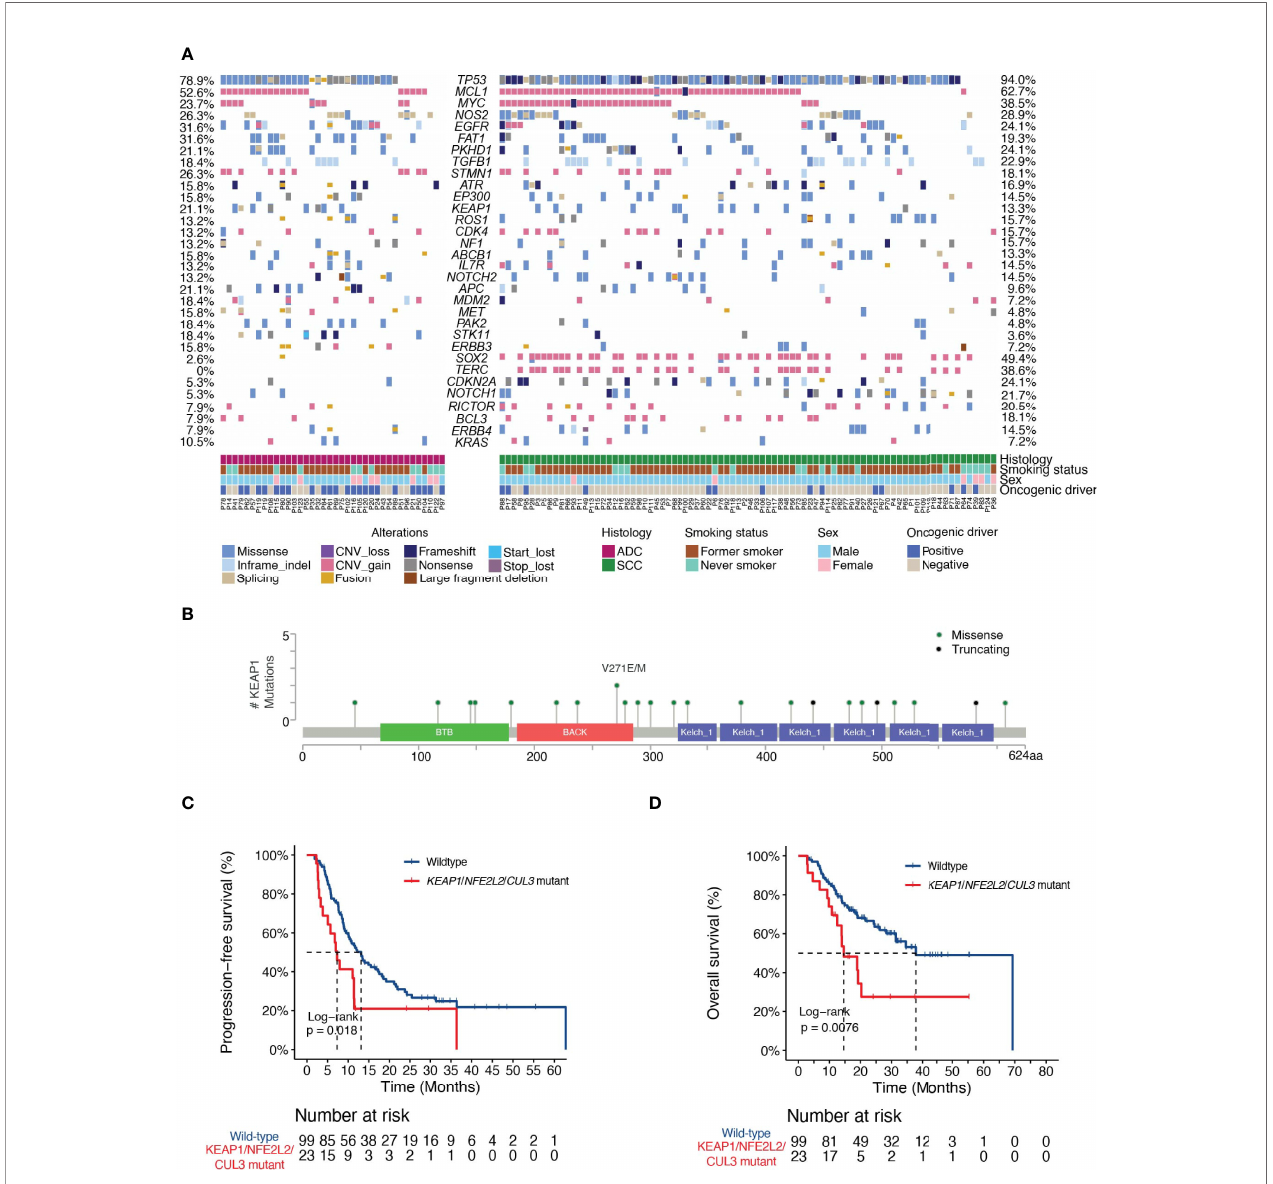
FIGURE 1 | Landscape of genetic variations and the associations of dCRT survival outcomes with the KEAP1-NRF2 pathway. (A) The distribution of various genetic variations in each patient was shown. Clinical characteristics of each patient were shown at the bottom. ADC, adenocarcinoma; SCC, squamous cell carcinoma. (B) Lollipop plot showing the distribution of KEAP1 mutations in the study cohort. (C, D) Kaplan-Meier estimates of (C) PFS and (D) OS in the full analysis set comparing patients with and without KEAP1-NRF2 pathway gene mutations. HR denotes hazard ratio; CI denotes con fi dence interval. Tick marks indicate censored